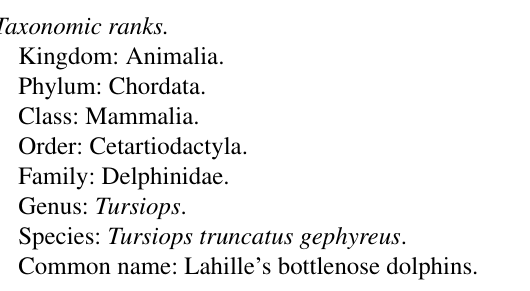
gephyreus (dataset